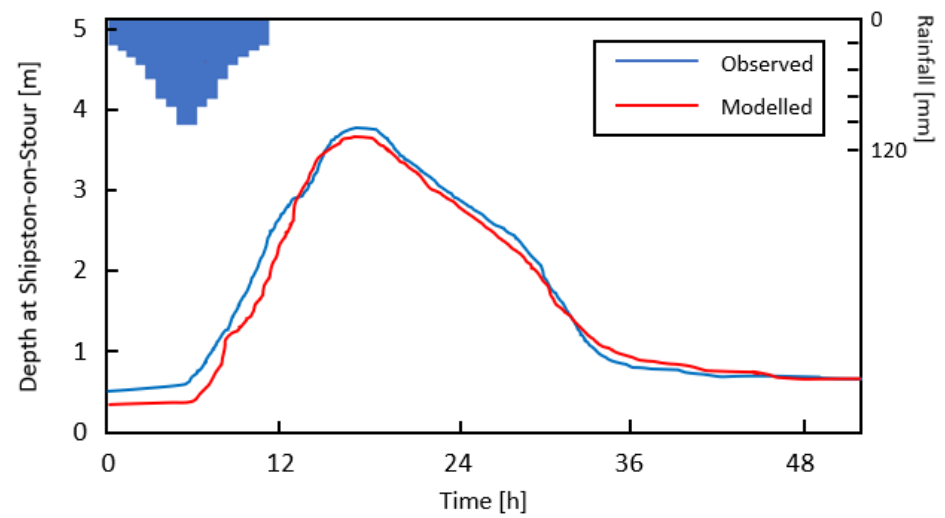
Figure 6. Model sensitivity of whole catchment to Shipston-on-Stour outlet.